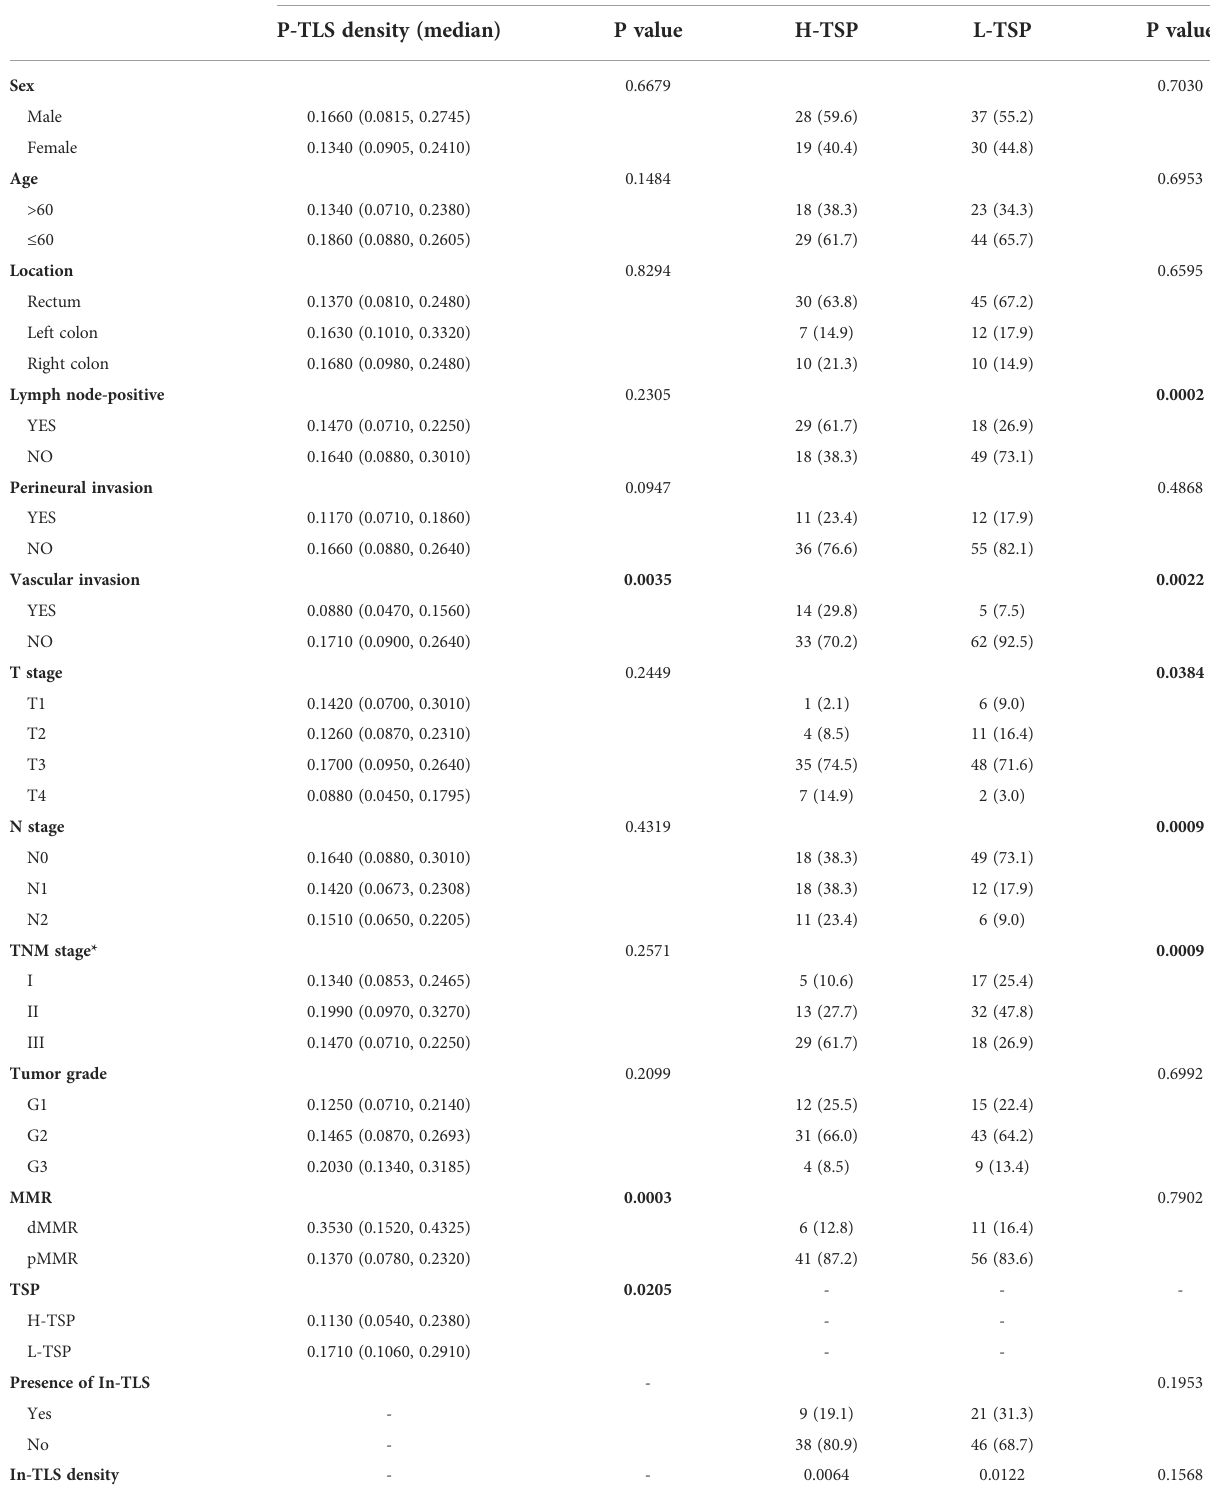
TABLE 2 Relationship of TSP and TLS with clinicopathological characteristics of nmCRC patients in the training set.